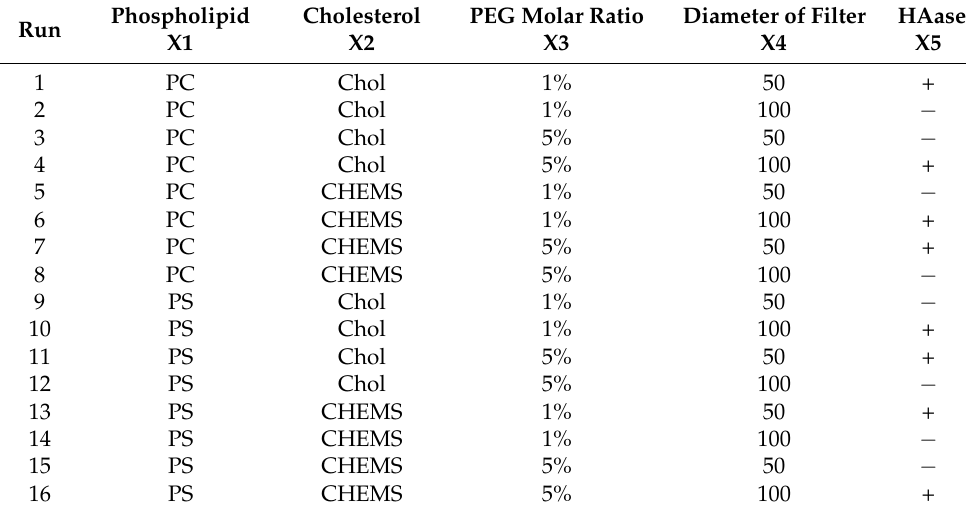
Table 1. Experimental matrix of